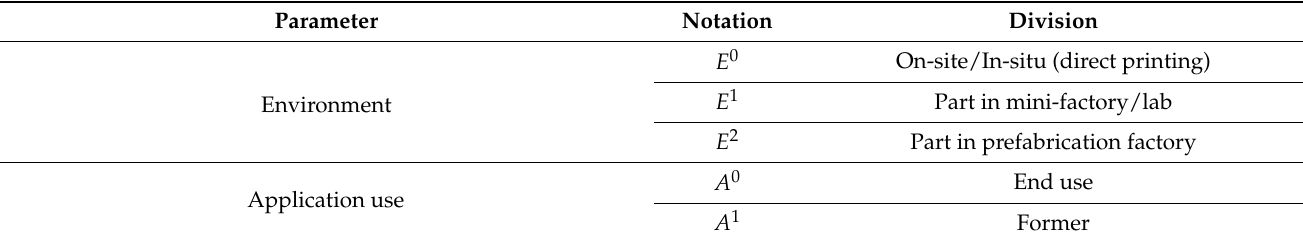
Table 10. The classification framework of E3DCP based on 12 parameters relating to the environment, application use, principal process mechanical